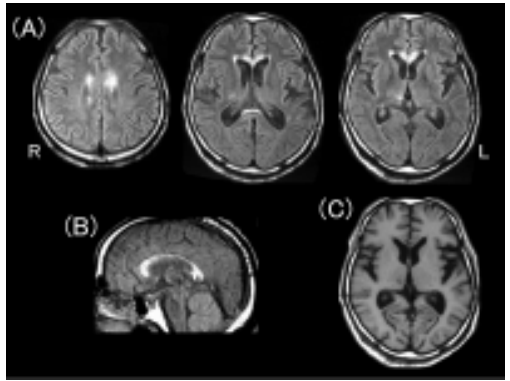
Fig. 1. Magnetic resonance imaging (MRI) performed 82 days after onset. Fluid attenuated inversion recovery (FLAIR) images in (A) axial and (B) sagittal planes revealed a symmetrical hyperintensity area in the genu, body, and anterior splenium of the corpus callosum, suggesting demyelination of these areas. The most anterior parts of the genu and posterior splenium were preserved. An additional small lesion was detected in the medial portion of the right thalamus. T1-weighted image in the axial plane (C) showed a hypointensity area in the corpus callosum, which was a part of the hyperintensity area revealed in the FLAIR images, suggesting partial necrosis of the demyelinated lesion. The hypointensity area was also evident in the right thalamus, suggesting an